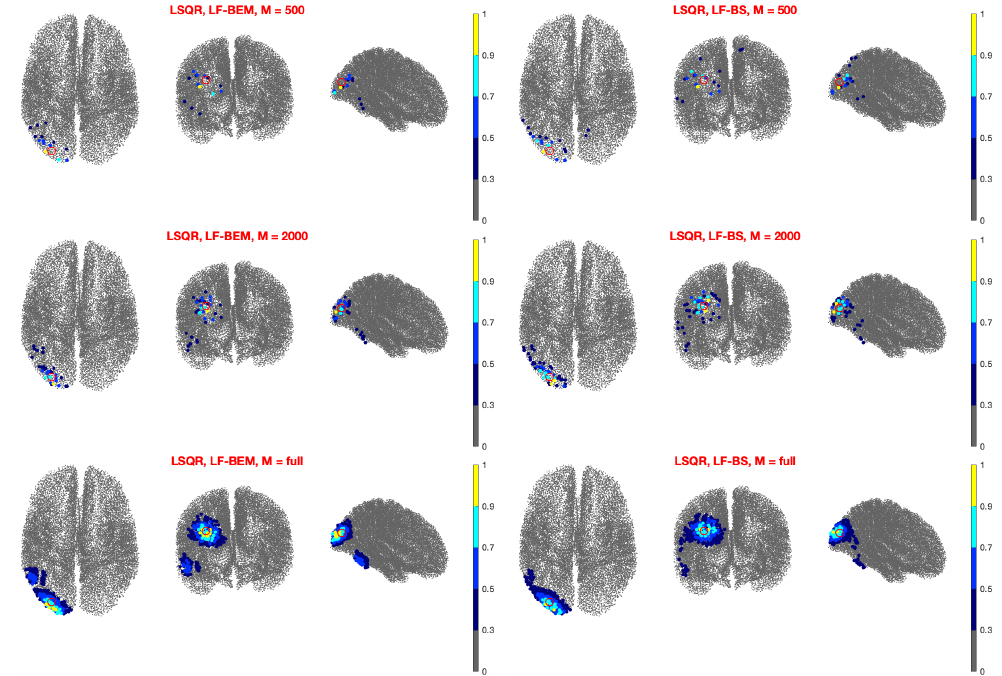
Figure 11. Right Visual evoked field: The intensity of the estimated sources, averaged over N = 10 runs, at 90 ms obtained using LSQR with M = 500 random points (first row), M = 2000 (second row) and the full source space (third row) for LF-BEM (left column) and LF-BS (right column). The red circle represents the dipole fitted using